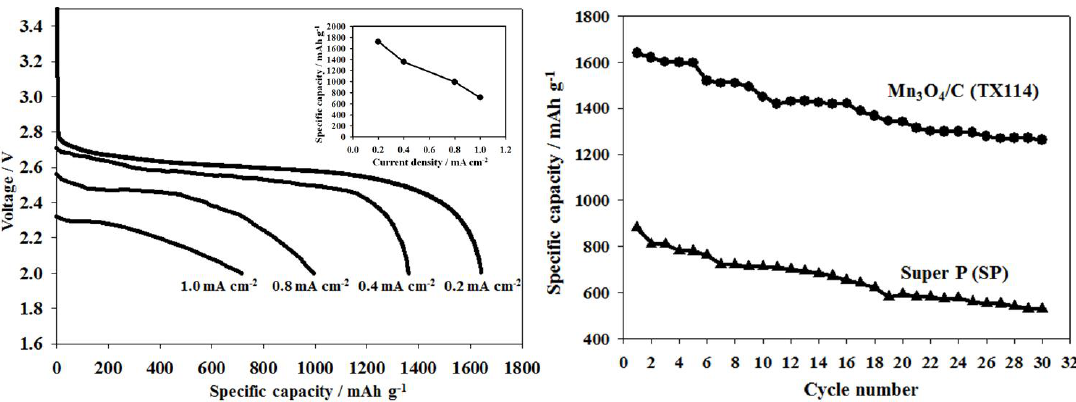
Figure 7. ( a ) Discharge curves at different current densities ranging from 0.2 mA·cm −2 to 1.0 mA·cm −2 for TX114. The insert is the discharge capacities at various current densities; ( b ) Cycle performance for TX114 and SP at a current density of 0.2 mA·cm −2 .